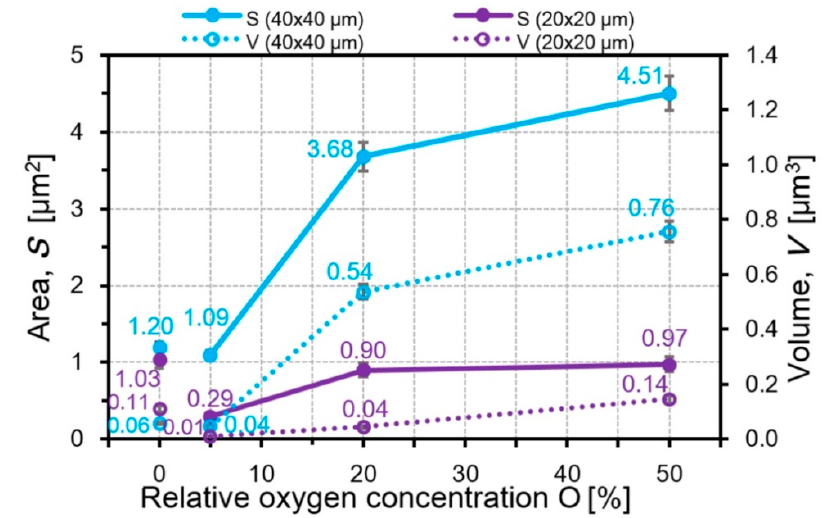
Figure 12. The dependences of the particle height and diameter from the oxygen content in the CrON coatings.